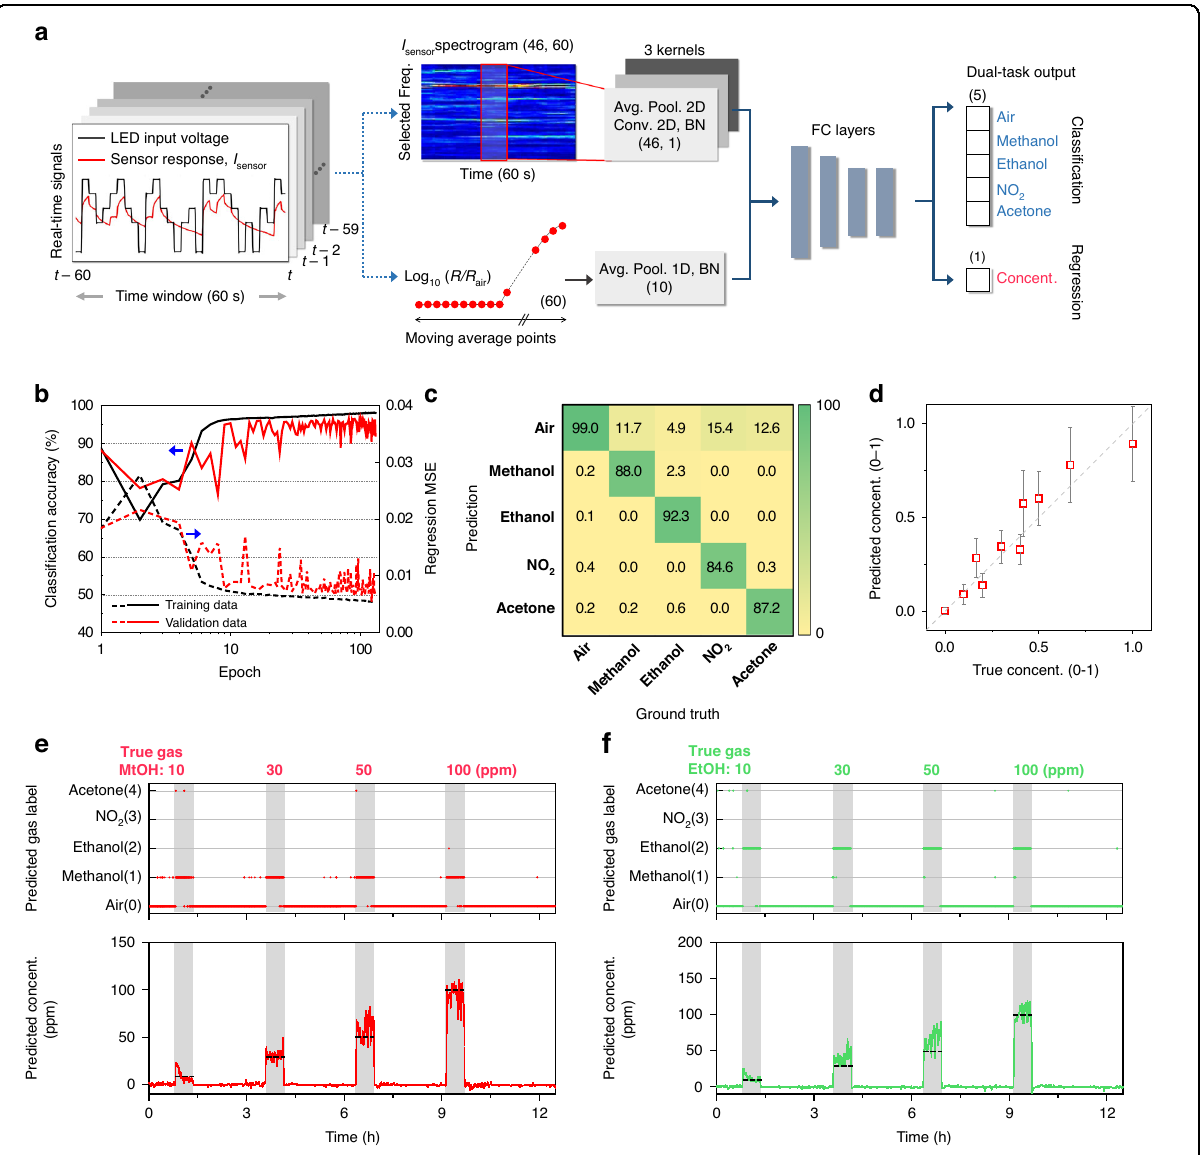
Fig. 3 Deep-learning-based identi fi cation of mono-gas environment. a Architecture of deep convolutional neural network (D-CNN) for classifying fi ve gas species (air, methanol, ethanol, NO 2 , and acetone) and for quantifying the concentrations of each gas. b Classi fi cation accuracy and regression loss for the training and validation datasets with respect to the training iterations. c , d Gas species prediction results summarized in a confusion matrix and gas concentrations normalized to 0 – 1 for test dataset. The predicted gas concentrations are close to the identity line ( y = x ) with r 2 = 0.888. e , f Real-time prediction of gas species and concentrations of methanol and ethanol. Here, normalized gas concentrations are converted to ppm by multiplying the maximum tested concentration of each